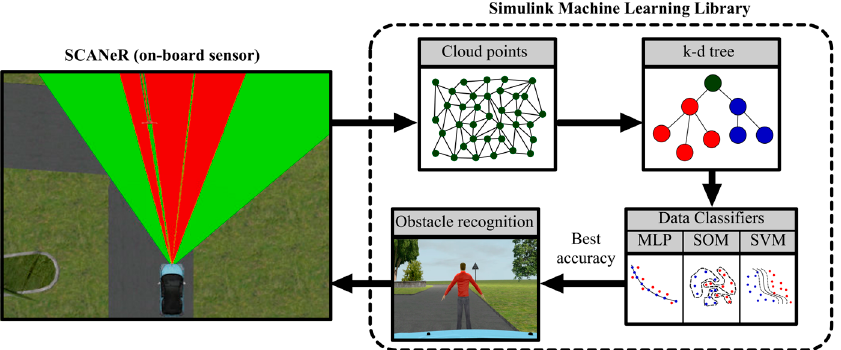
Figure 6. Obstacle detection close-loop for each virtual CPS sensor.